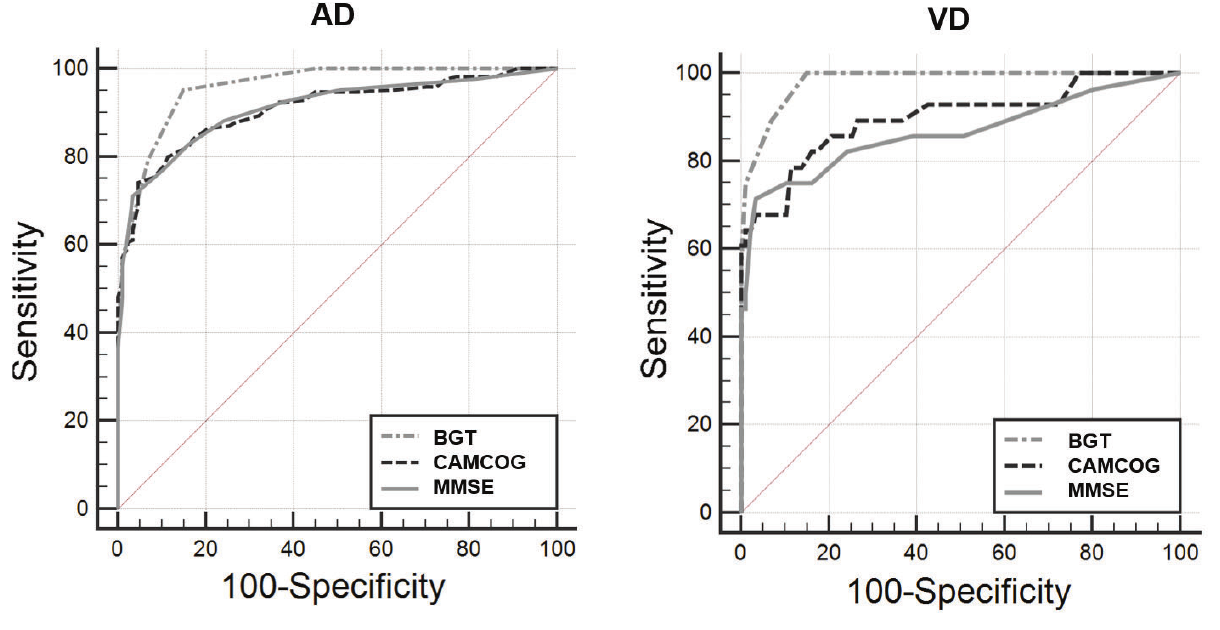
Figure 1 - Graphical analysis of the ROC curve between control and elderly subjects with AD groups showing comparisons between cognitive instruments. AD group: representation of the largest area under the curve (AUC) evidenced by the Bender Gestalt Test, followed by the MMSE (B) and CAMCOG (C). VD: representation of the largest area under the curve (AUC) evidenced by the Bender Gestalt Test, followed by CAMCOG and MMSE.